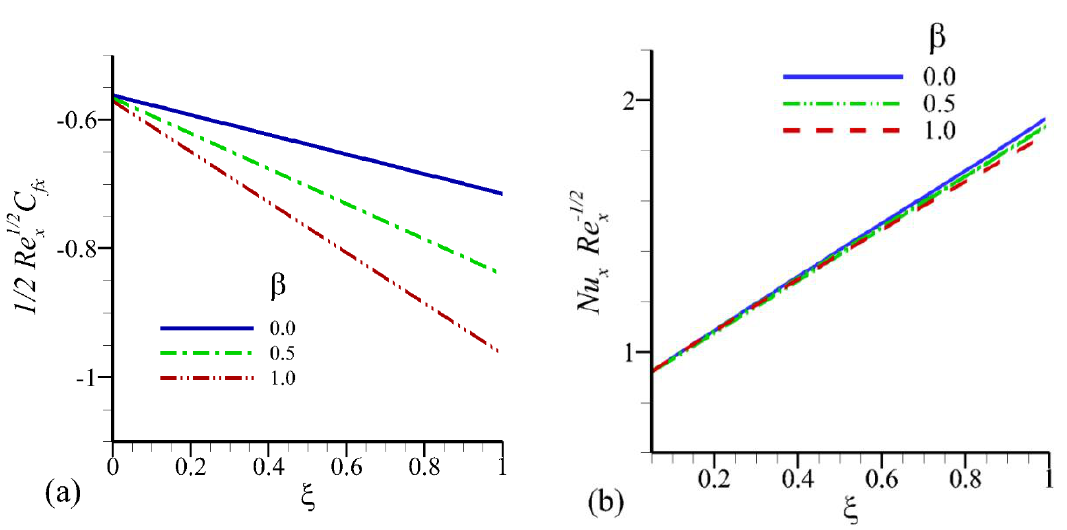
− 1/2 ξ for changing values of β while Pr = λ = 1.0 x with